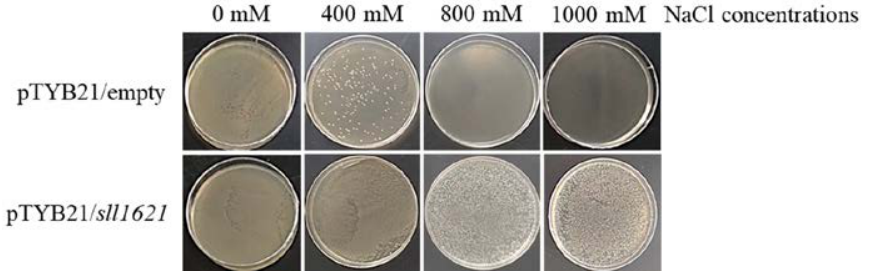
Fig. 4. Impact of various concentrations of NaCl on the growth of recombinant pTYB21/ sll1621 and pTYB21 /empty E. coli cells. Full conditions for experiments are depicted in ‘‘Materials and Methods